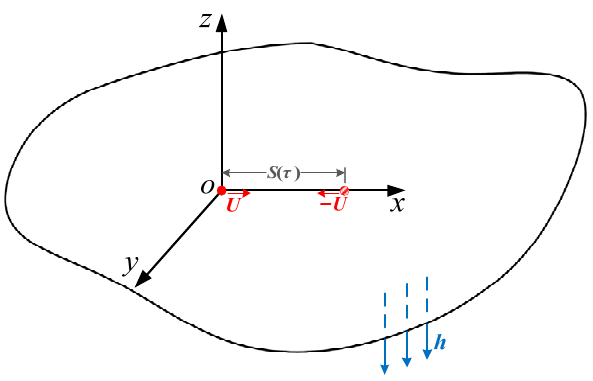
Figure 4. Semi-infinite medium subjected to reciprocating a point heat source.